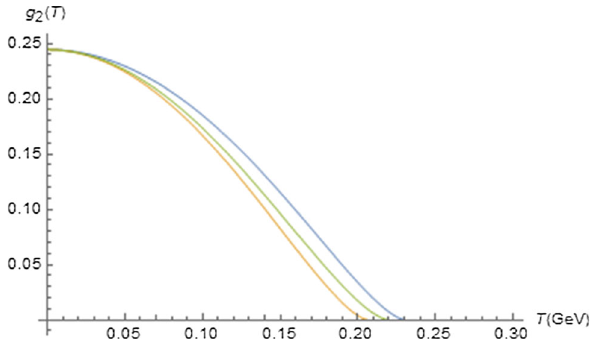
Fig. 3 g 2 ( T ) term at N f = 2, F = 87 MeV (green line); N f = 3, F = 100 MeV (blue line); N f = 5, F = 140 MeV (orange line)